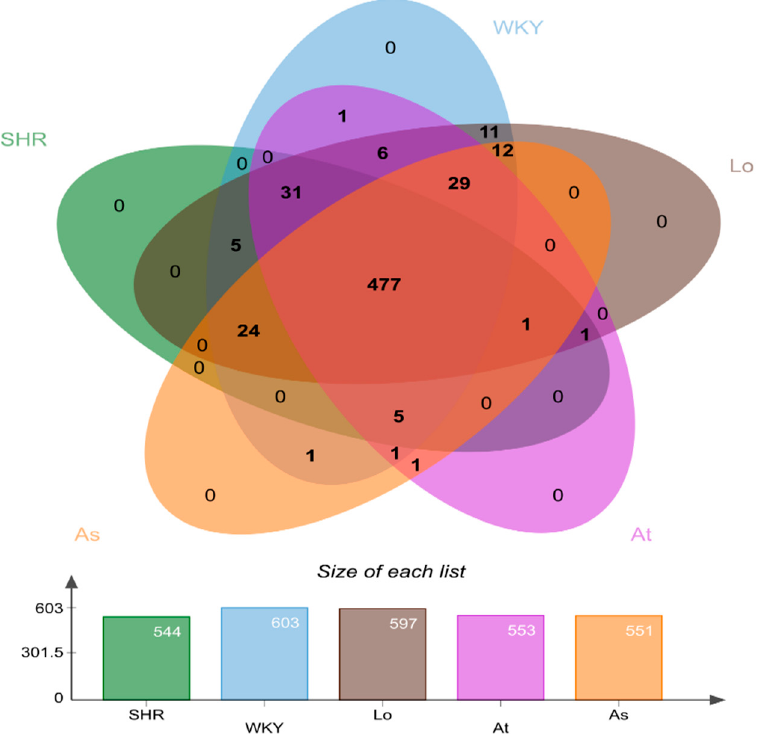
Figure 3. Venn plot of operational taxonomic units (OTUs) distribution of 5 groups of samples. Different groups are represented by different colors, and the overlapping number of different color graphs is the number of common features between groups.